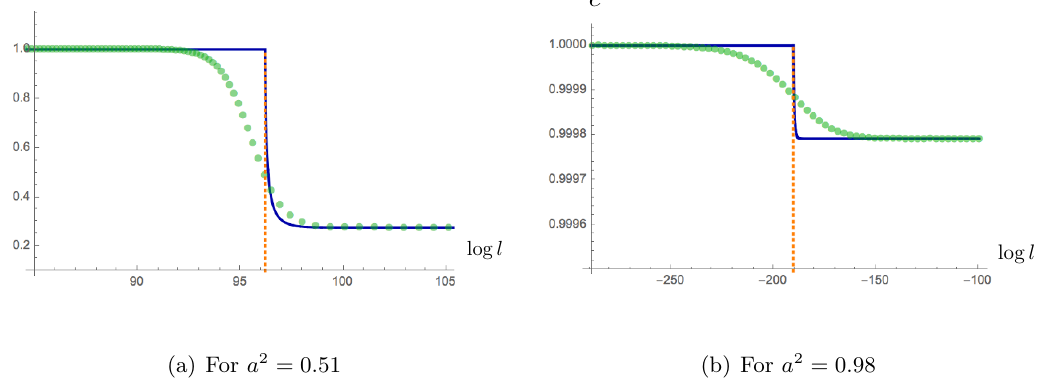
Figure 4 . (color online) The entropic c-function evaluated in the AdS uv (cid:13)ows with di(cid:11)erent values of a . The reference central charge of AdS uv dotted orange line is the position of the thin-wall, y DW = log(2 =‘ DW ), where we assumed that y DW satis(cid:12)es the conditions, A 0 ( y DW ) < 0 and A 00 ( y DW ) = 0. The AdS ir the numerically computed values for large values of l